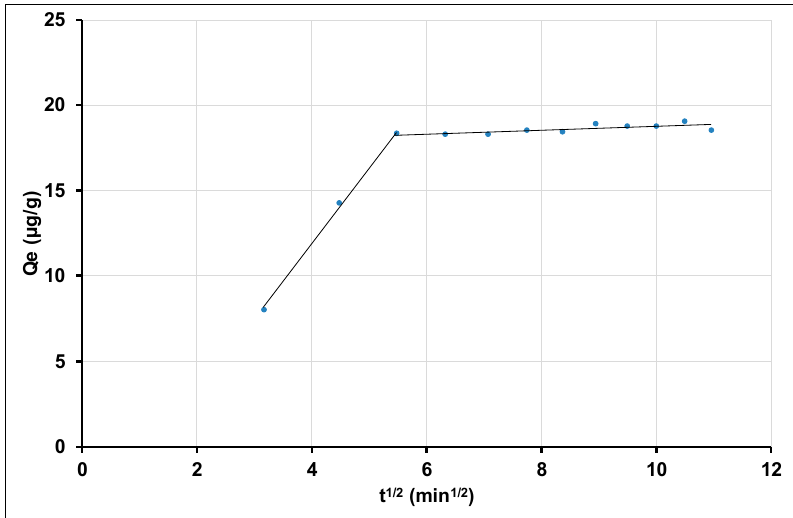
Figure 11. Intra-particle diffusion modeling for the adsorption of Tl(I) on the gamma-alumina nanoparticles.